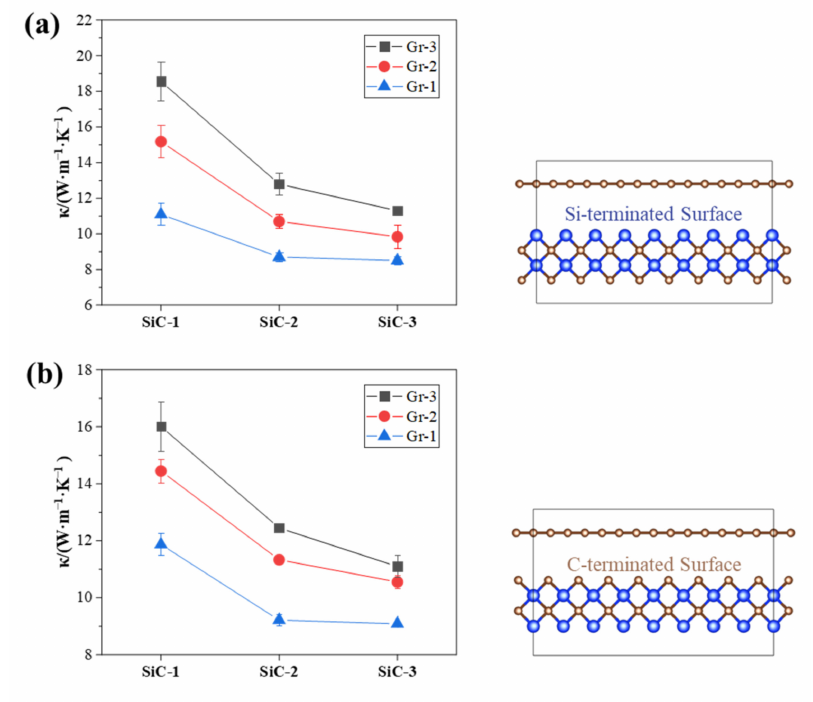
Figure 3. Thermal conductivities and schematic structure of GS-Hs on ( a ) C-terminated sur- face and ( b ) Si-terminated surface. The error bars are the standard deviation obtained from 3 separate